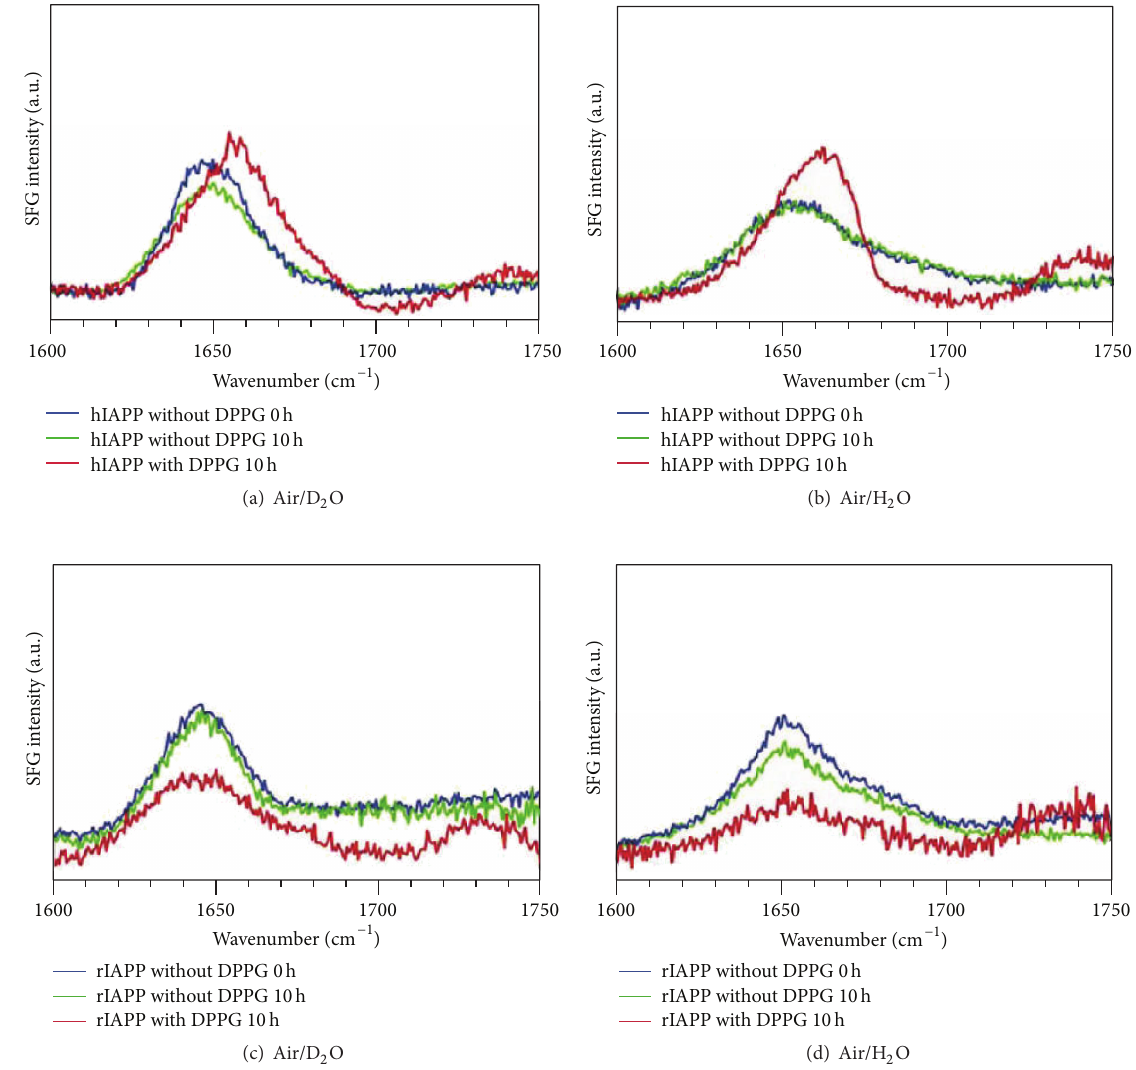
Figure 1: The ssp (achiral) SFG spectra of IAPPs. Human IAPP without DPPG ( 𝑡 = 0 h and 𝑡 = 10 h) and with DPPG at 𝑡 = 10 h at the (a) air/D 2 O and (b) air/H 2 O interfaces; rat IAPP without DPPG ( 𝑡 = 0 h and 𝑡 = 10 h) and with DPPG at 𝑡 = 10 h at the (c) air/D 2 O and (d) air/H 2 O interfaces. Adapted from [62] with permission. Copyright 2010 American Chemical